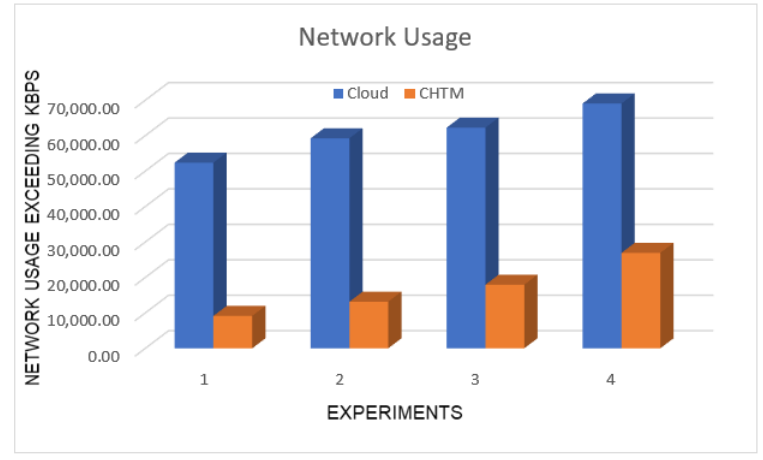
Figure 5. Network usage comparison.